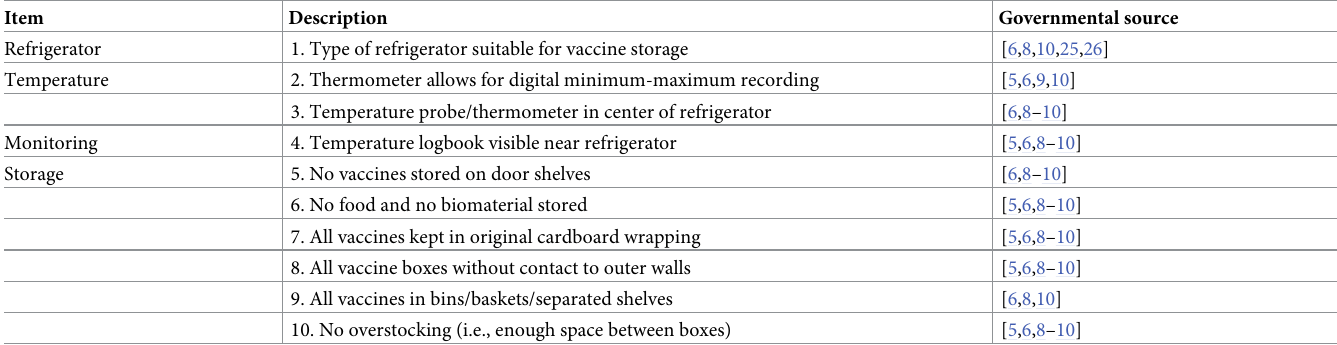
Table 1. Quality indicator ’good refrigerator management’ (10